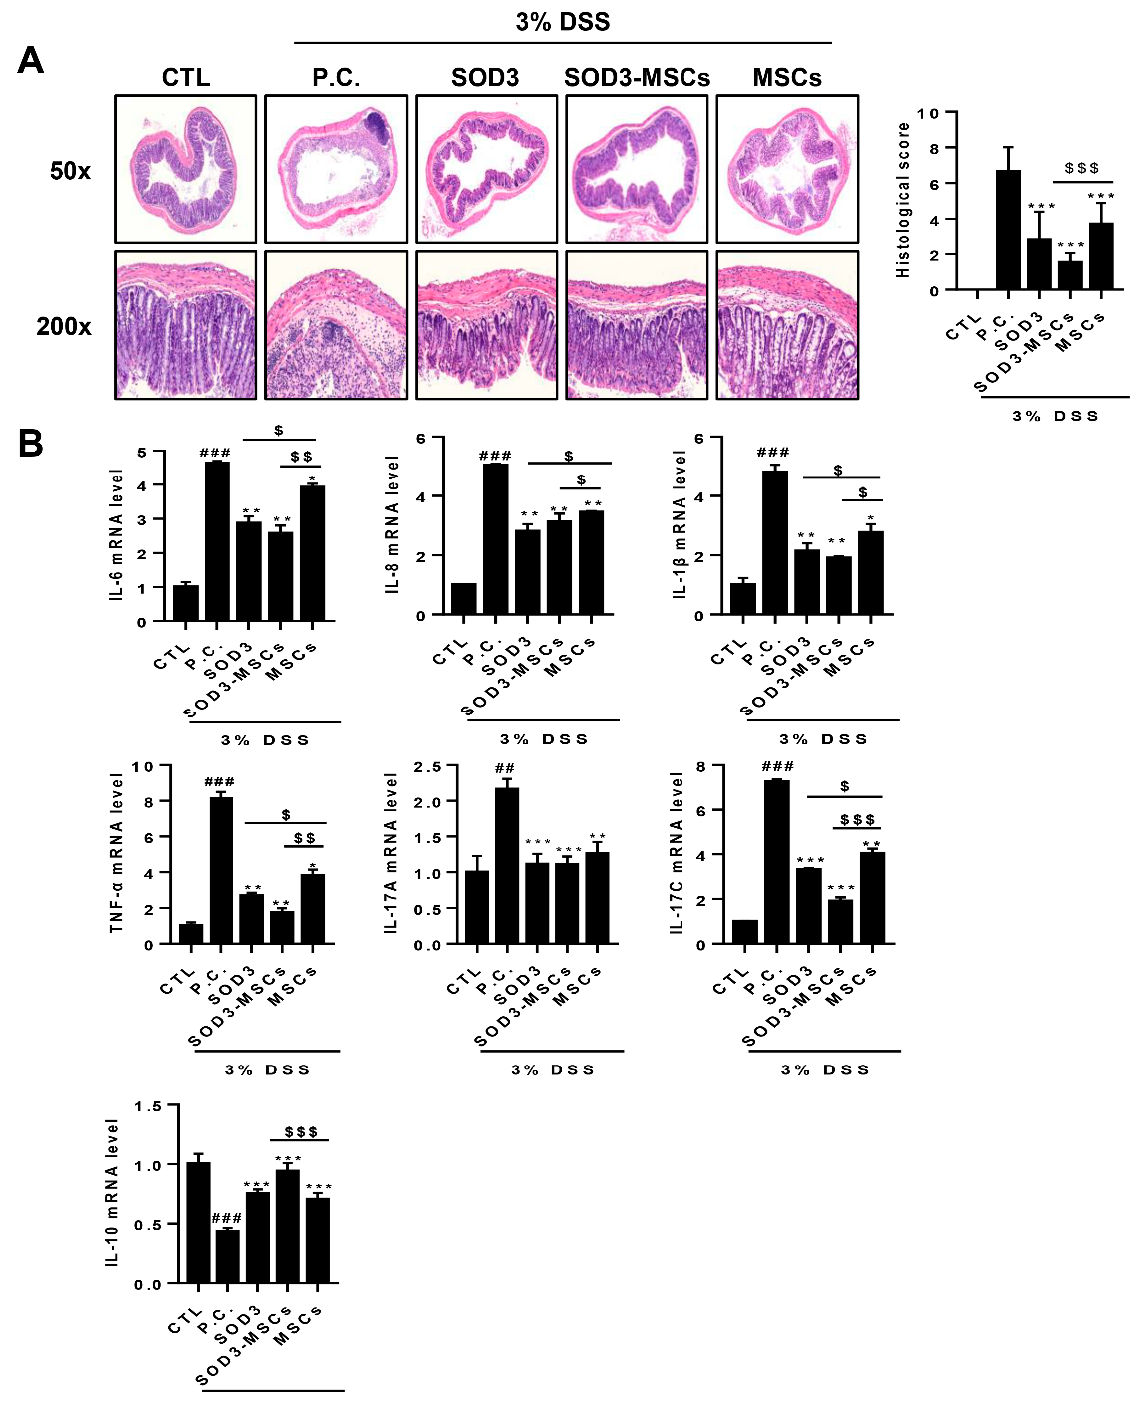
Figure 4. Histological and molecular analysis of colon samples from SOD3- or SOD3-MSC-treated mice. Colon sections were prepared and H&E staining was performed. ( A ) H&E stained sections were photographed and representative pictures are shown. Histopathological scores were measured by analyzing epithelial destruction and lymphocyte infiltration. ( B ) The expressions of pro- or anti-inflammatory genes in the colon were determined by real-time PCR. ## p < 0.01, ### p < 0.001 (CTL vs. P.C), * p < 0.05, ** p < 0.01, *** p < 0.001 (P.C vs. SOD3, SOD3-MSCs and MSCs), $ p < 0.05, $$ p < 0.01, $$$ p < 0.001 (SOD3, SOD3-MSCs vs.